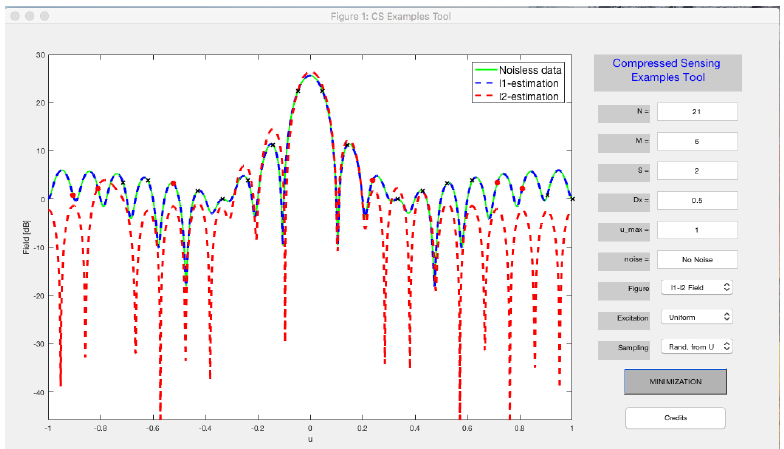
Figure 14. CS/SR reconstraction from noiseless measured; N = 21 radiating elements, S = 2 failures, M = 6 measurement points (plotted as red circles in the figures); figure from the CS Examples Tool program.